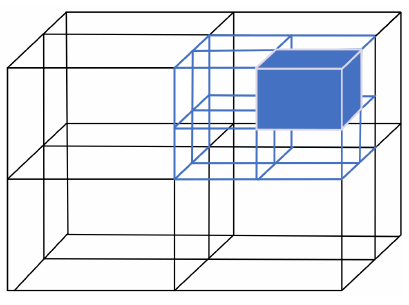
Figure 4. Schematic diagram of octree.